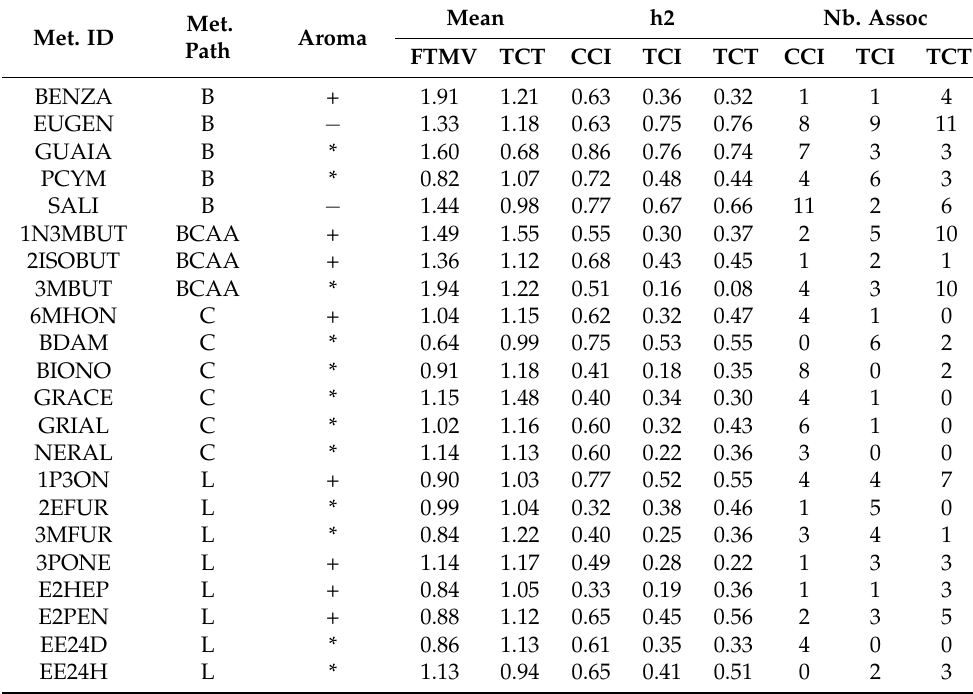
Figure 2. PLS-DA on VOC and sugar content in the three genetic groups of the TCT panel. ( a ) F1 hybrid plot. Each colour corresponds to a genetic group in the TCT panel. ( b ) VOCs maximizing the discrimination between the genetic groups on the first axis of the F1 hybrid plot. The colour of the contribution highlights the genetic group which shows enrichment in the corresponding VOC. The direction of the contribution depends on the position of the genetic group. VOC impact on tomato aroma is indicated at the end of the VOC name as presented in Table 1. +: positive correlation to consumer liking, − : negative correlation to consumer liking, *: impacts flavour perception. Table 2. GWAS summary for SSC and VOCs impacting tomato